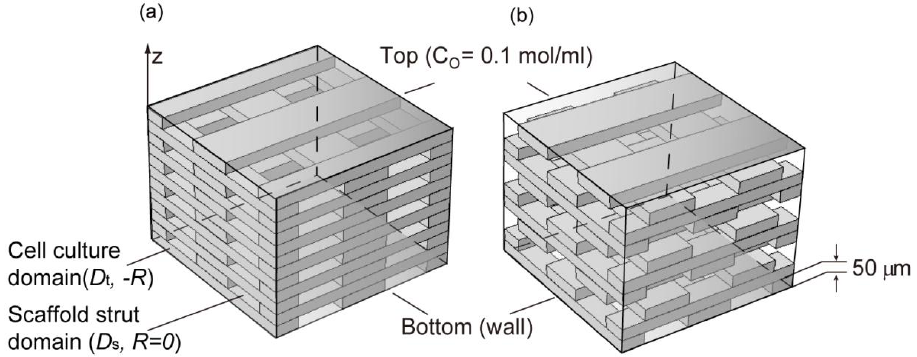
Figure 8. Schematic representation of the simulation domain. ( a ) Lattice model; ( b ) Staggered model.